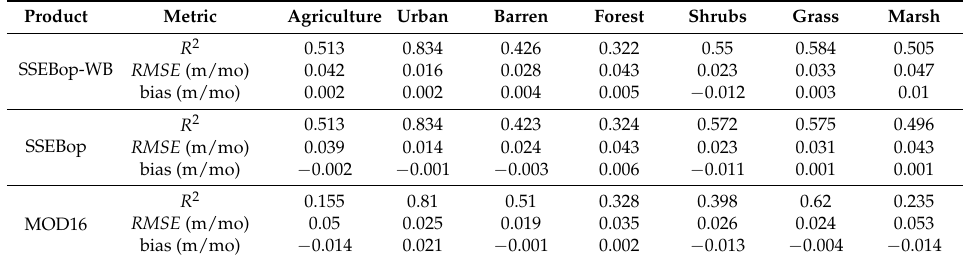
Table 2. Monthly statistical metrics for the different methods by land cover type from the 2006 NLCD. The R 2 , RMSE , and bias of each method when compared with AmeriFlux data are listed for each land cover type. Barren Forest